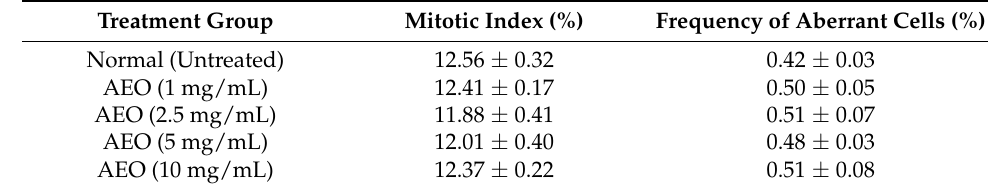
Table 4. Genotoxicity assay of Allspice essential oil (AEO) in model Allium cepa mitotic cells.